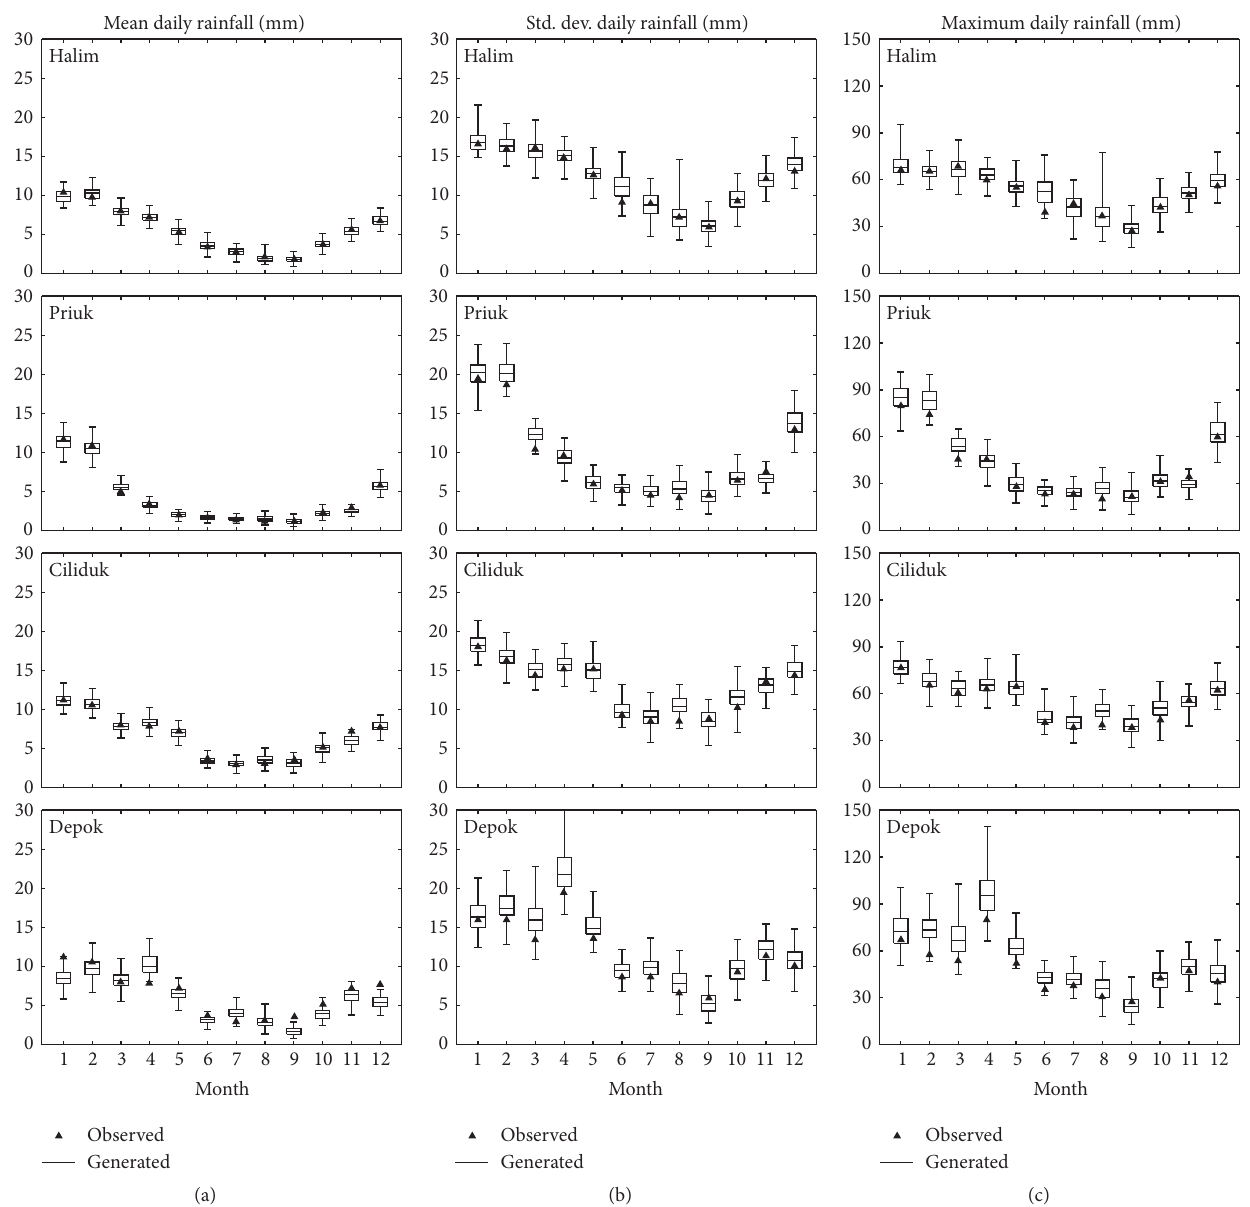
Figure 3: Comparison of observed mean (a), standard deviation (b), and maximum daily rainfall (c) with LARS-WG generated rainfall sequences at the four stations. The observed data are for the period of 1984–2006. The boxplots are derived from 100 independent realizations of 23-year-long LARS-WG generated data. Whiskers indicate minimum and maximum out of 100